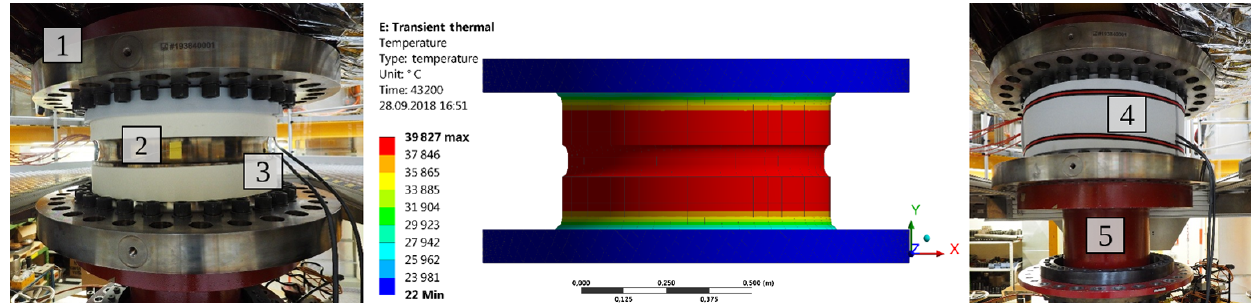
Figure 3. Heat blanket (3) around the 5MNm TTS (1), which is installed in the 1.1MNm torque standard machine (5) taped with five Pt100 sensors (2), and isolated by Basotect foam